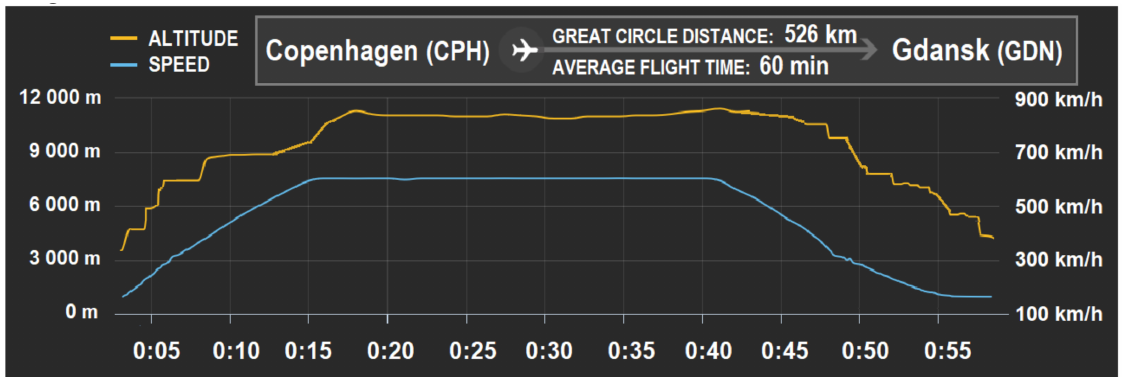
Figure 3. Main parameters of the flight trajectory from Copenhagen airport to Gdansk airport